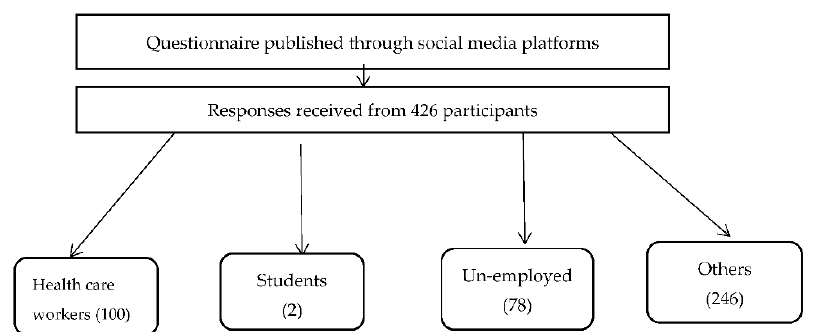
Figure 1. Flow chart of 426 participants in the survey.